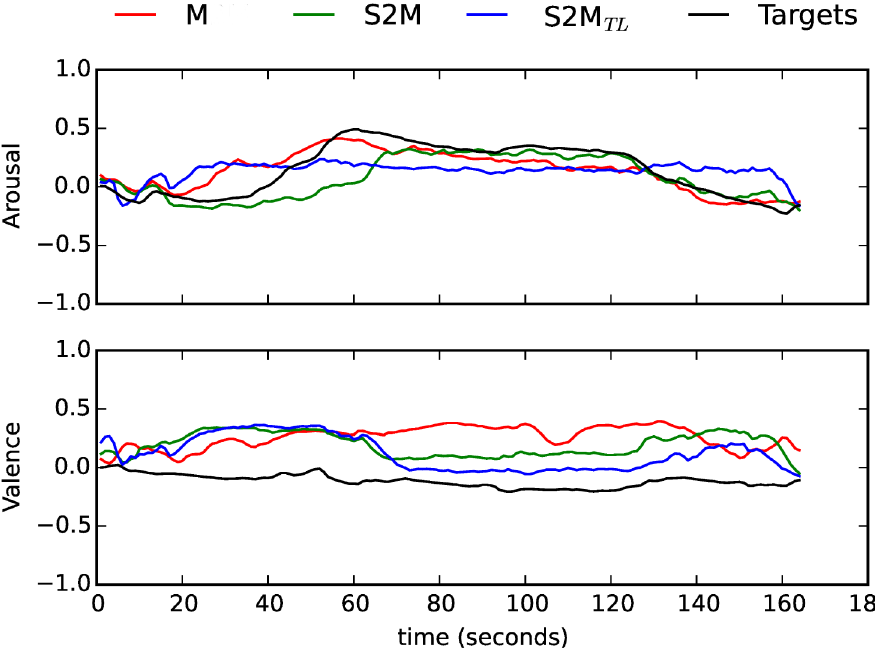
Fig 2. Time-continuous Arousal and Valence predictions by the intra- ( M ) and cross-domain ( S 2 M , S 2 M TL ) models for M inority Report, Main Theme (taken from M DB is also shown